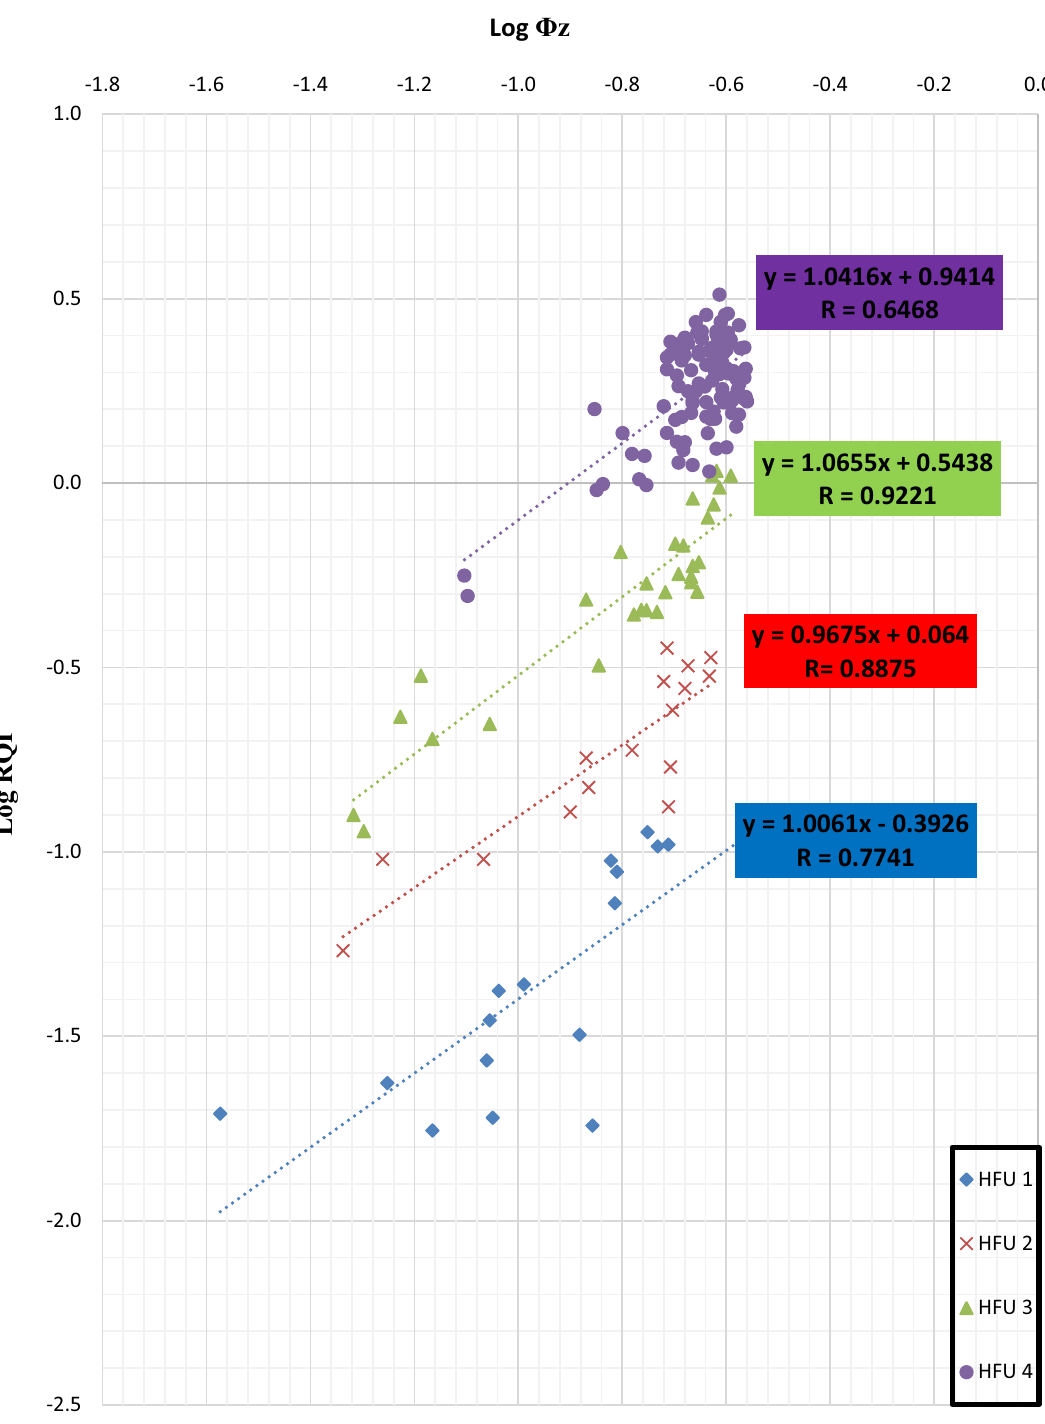
Fig. 8 Clustering core data into the optimal number of HFUs using IMLR